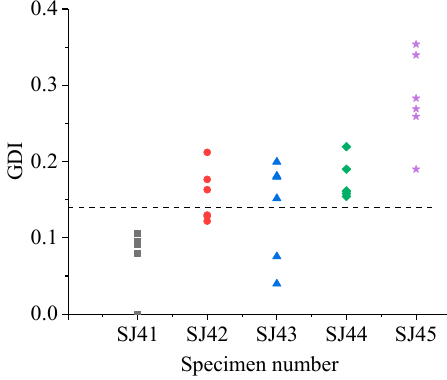
Figure 14. GDI of specimens in the SJ4 group.